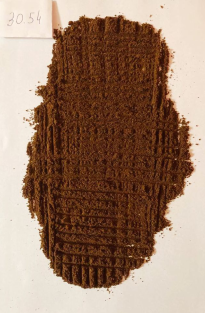
Figure 21. Coffee beans ground for about 30